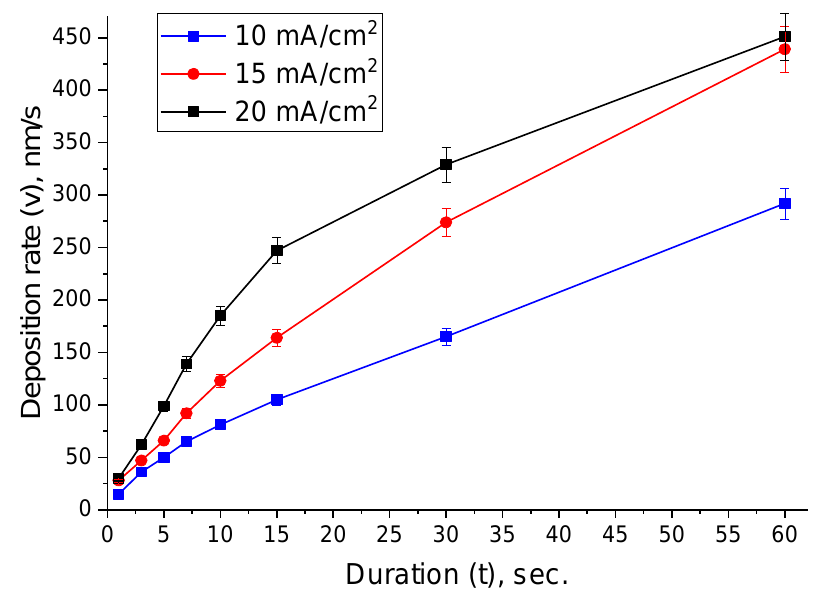
Figure 3. Dependence of deposition rate on duration for samples obtained with D c from 10 to 20 mA/cm 2